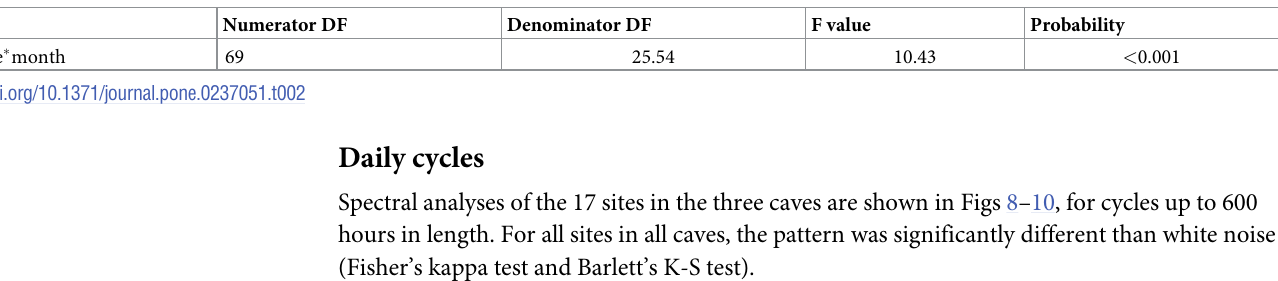
Table 2. Type III Tests of Fixed Effects based on GLIMMIX model.